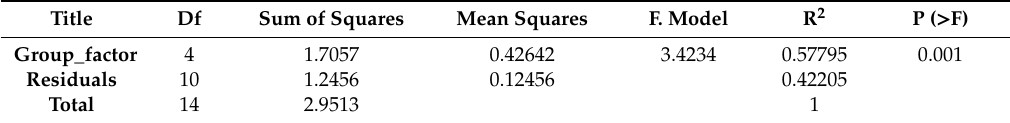
Table 3. Composition of fungi among the four treatments by the Adonis analysis method.